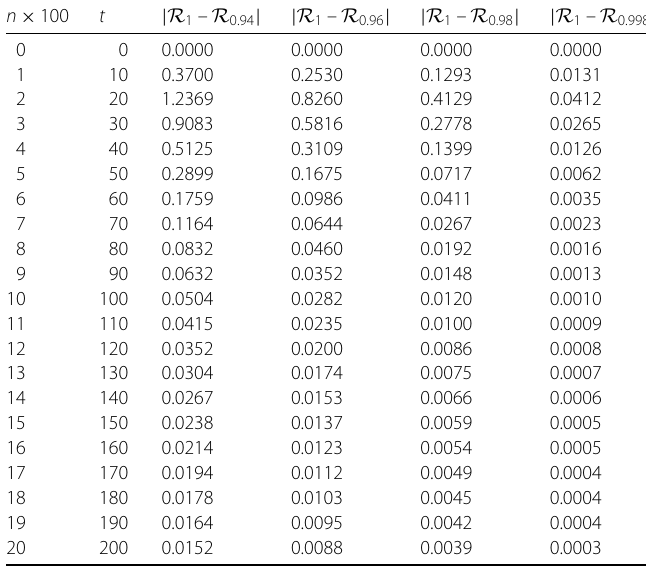
Table 5 The values of | R 1 – R φ | for φ = { 0.94,0.96,0.98,0.998 }